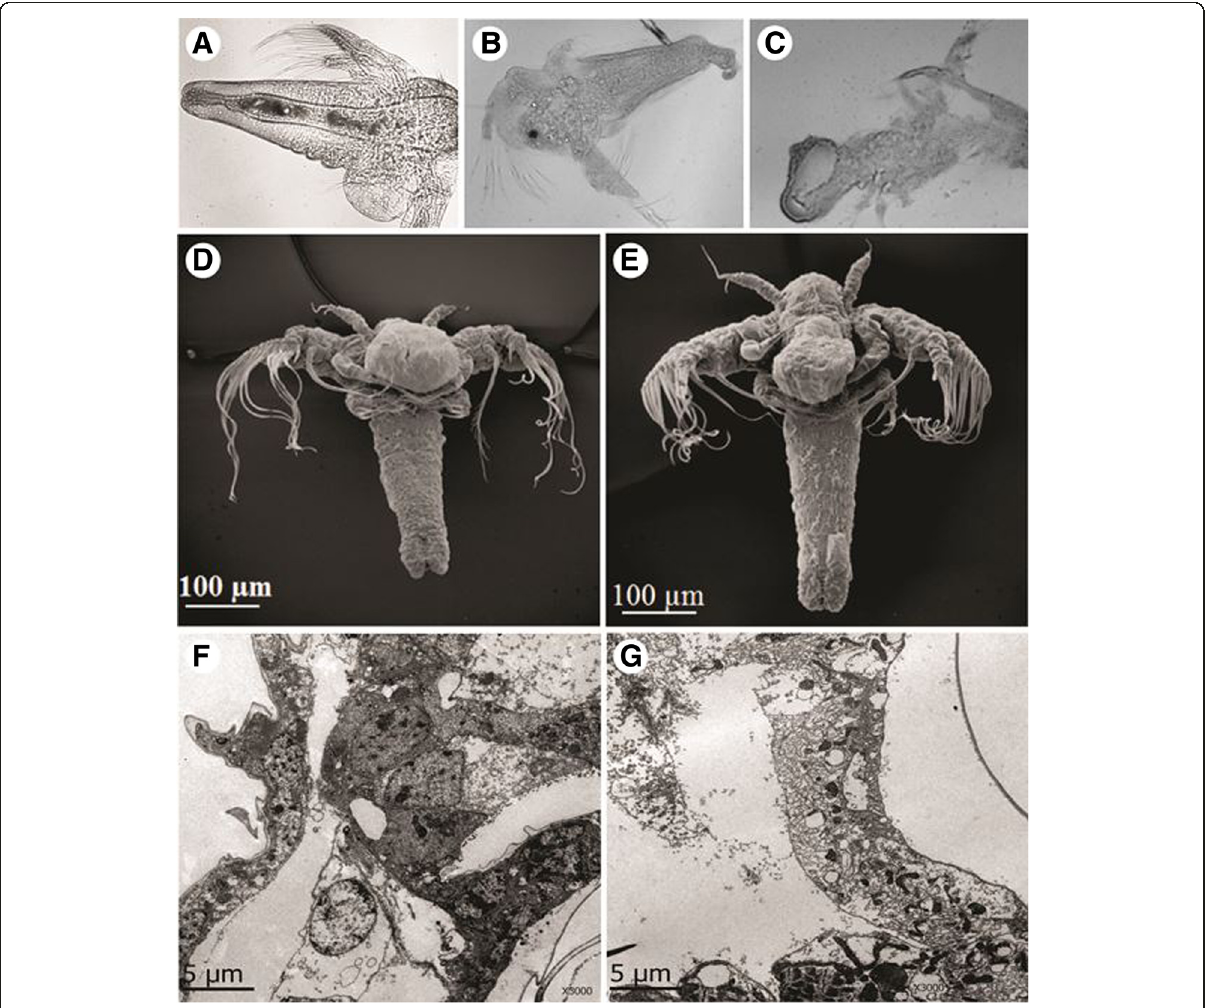
Fig. 7 a Artemia salina brine shrimp used as control, after 24-h incubation in seawater. b and c Brine shrimps after 24 h of incubation with 10-fold the LD 50 of the M. alcicornis aqueous extract; membranes are partially disintegrated. Light microscope, 400× magnification. d Control and ( e ) treated brine shrimp by SEM. Ultrathin longitudinal sections of ( f ) control and ( g ) treated brine shrimps by